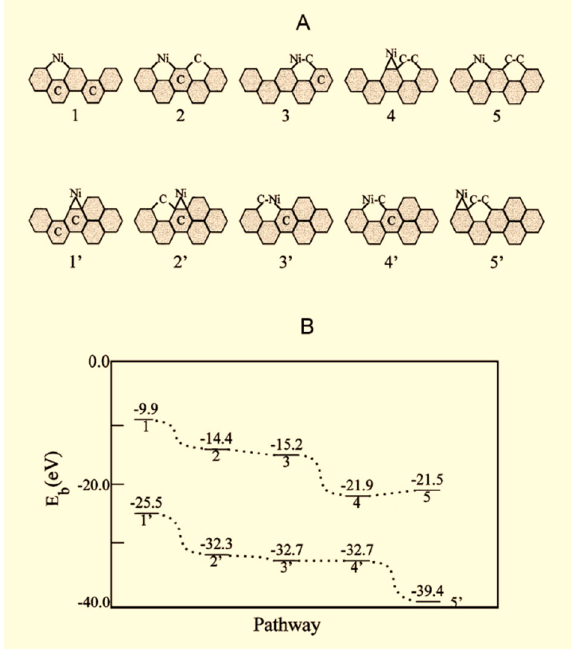
Fig. 10 The intermediate steps involved in the catalytic growth of a SWCNT as well as the binding energies. A Schematic diagram of intermediate steps involved in the catalytic annealing of pentagon defects at the growing nanotube edge by a concerted exchange mechanism, leading to defect-free growth. B Corresponding binding energies of the two carbon atoms and one Ni atom to the nanotube. Reproduced with permission from the American Physical Society 31